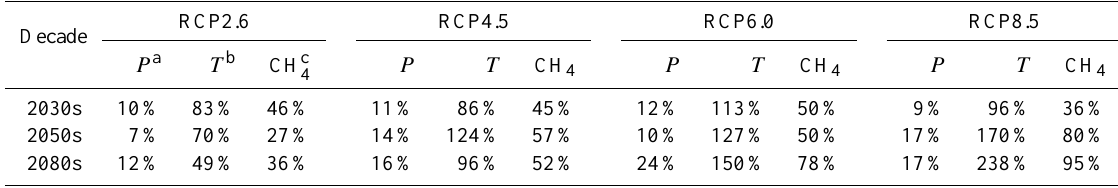
Table 4. Projected increases in area-weighted CH 4 flux relative to